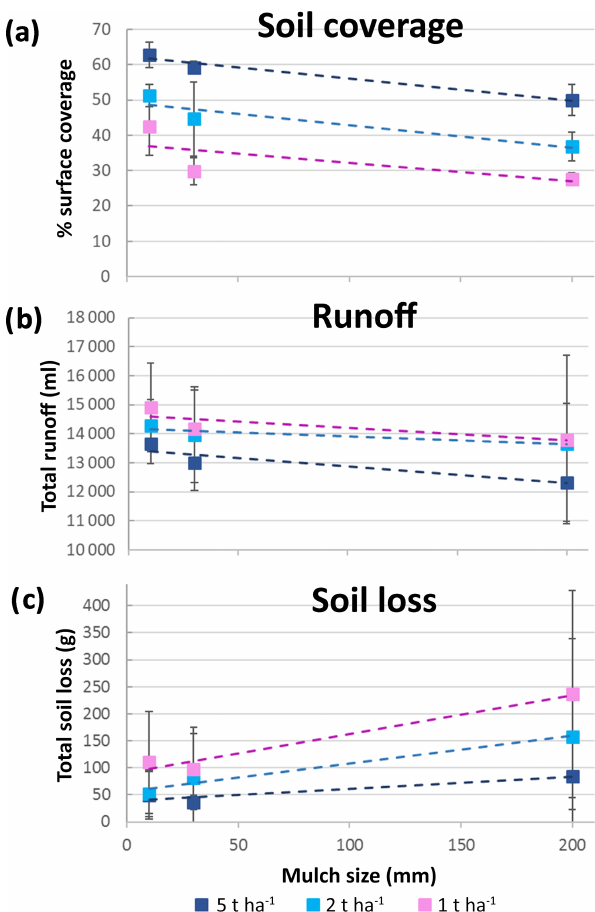
Figure 6. Response to different rice straw mulch sizes and applica- tion rates: (a) percentage of soil surface coverage by mulch, (b) to- tal runoff, and (c) total soil loss as a function of mulch size, for 10, 30 and 200mm, and for 3 application rates. Average and standard deviation bars are for 3